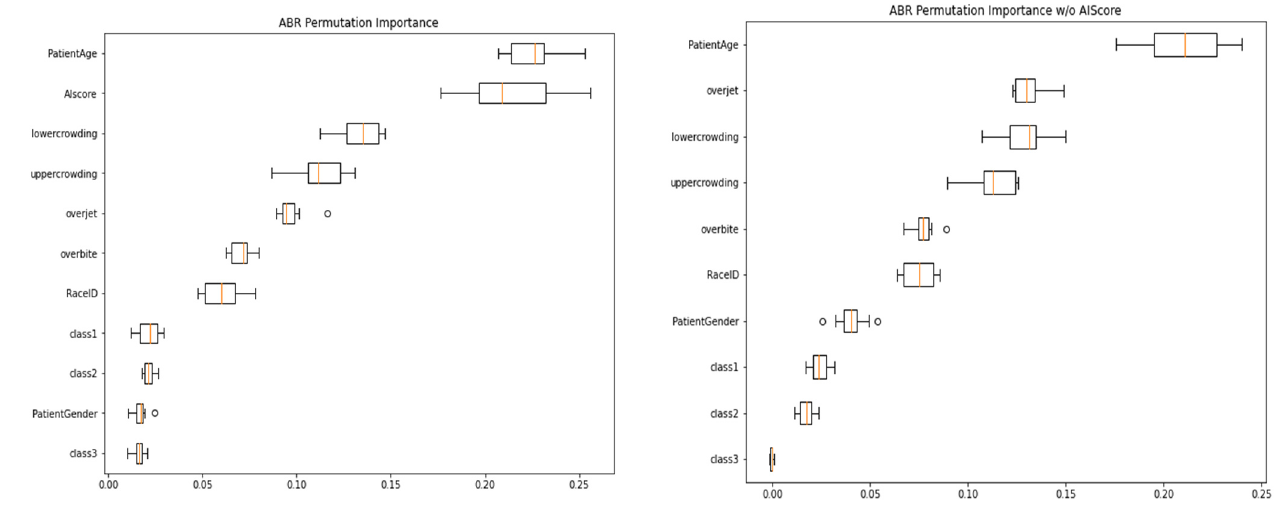
Figure 9. Permutation importance for the adaboost model.